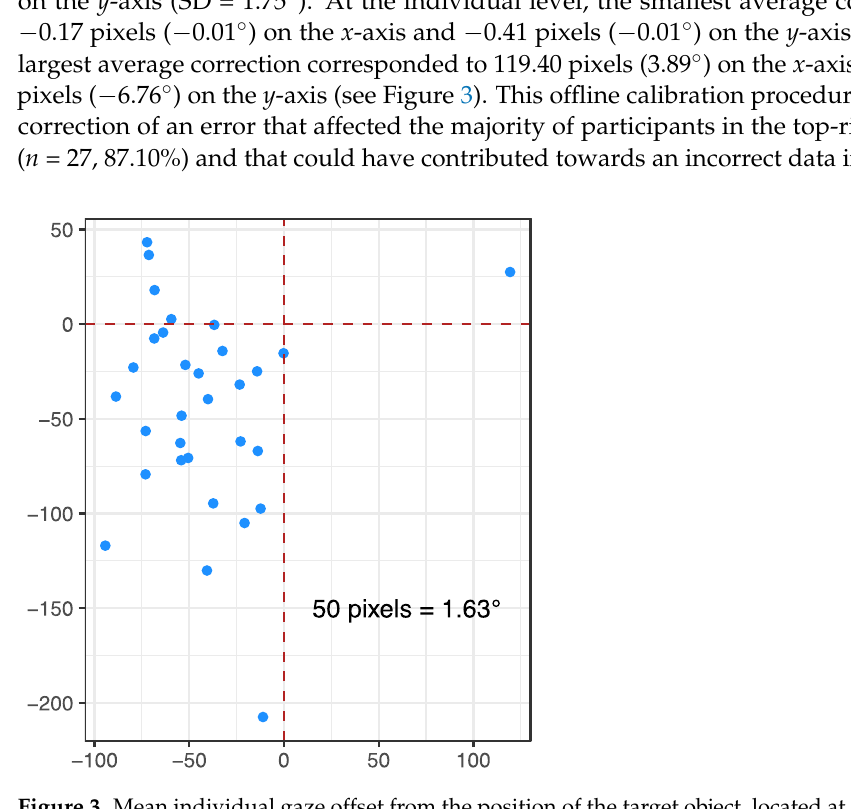
Figure 3. Mean individual gaze offset from the position of the target object, located at the intersection of the red dotted lines.